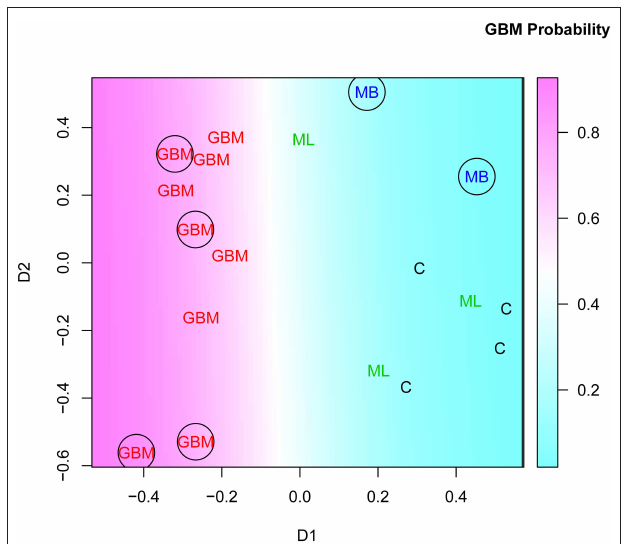
FIGURE 8 | Multidimensional scaling plot of cases in batch “R” based on the set of GBM-related features found in at least 15/28 of the “leave on out” patient groups. See Figure 7 and Supplementary Methods for details. The encircled points correspond to the testing set. GBM, glioblastoma